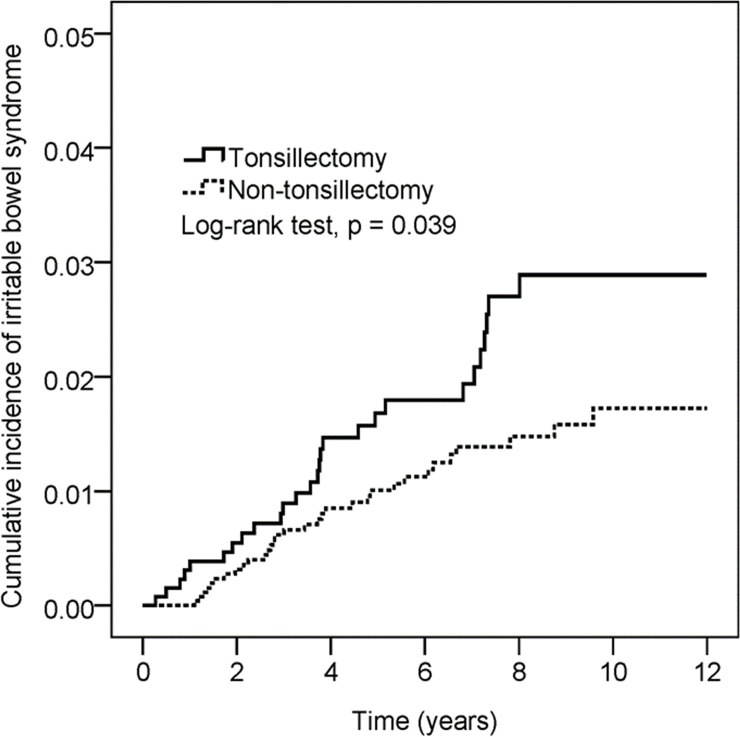
Kaplan–Meier curves of the cumulative probability of IBS in the study groups.